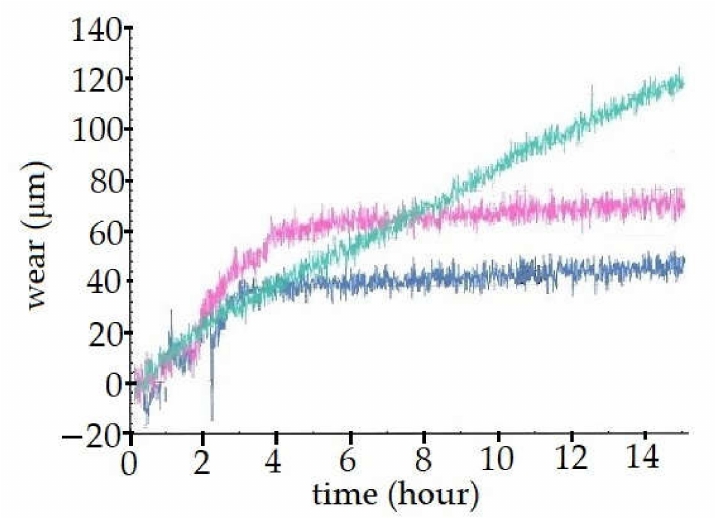
Figure 10. A comparison of the wear rate of the specimens of the S960QL steel welded by the electron beam (blue curve), the laser beam (red curve), and MAG technology (green